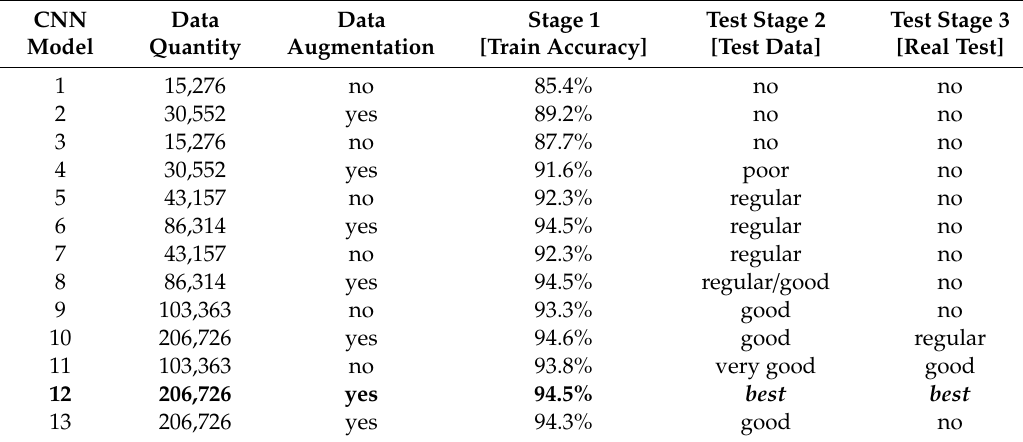
Table 6. Summary of the results of the